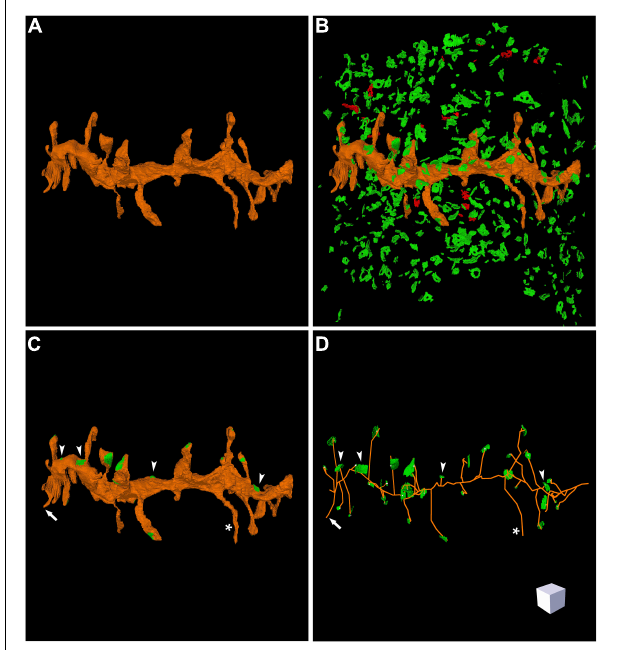
FIGURE 4 | Three-dimensional reconstruction of a labeled dendritic segment and the surrounding synaptic junctions. (A) Reconstructed dendritic segment showing multiple dendritic spines. (B) The synaptic junctions present in the neighboring tissue have been segmented and reconstructed. Excitatory synaptic junctions are represented in green and inhibitory synaptic junctions are shown in red. (C) The same dendritic segment has been rendered with its corresponding synaptic junctions (green). Most synapses are established on dendritic spines, but synapses on the dendritic shaft are also visible (arrow heads). One of the dendritic spines does not establish any synaptic contact (asterisk). (D) Skeletonized representation of the same dendrite with its corresponding synapses. Arrow heads point to synaptic junctions that are established on the dendritic shaft; the asterisk indicates one non-synaptic dendritic spine; the arrow points to a dendritic spine that was truncated by the edges of the stack of serial images, so no synapse could be found. Scale cube is 1 µ m on each side. See also Supplementary Video 2